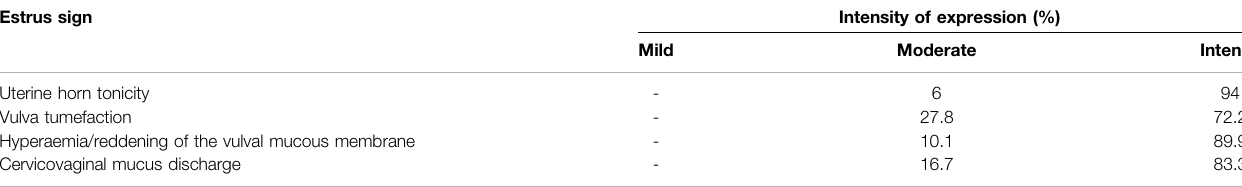
TABLE 2 | Intensity of expression of other estrus signs in buffaloes.